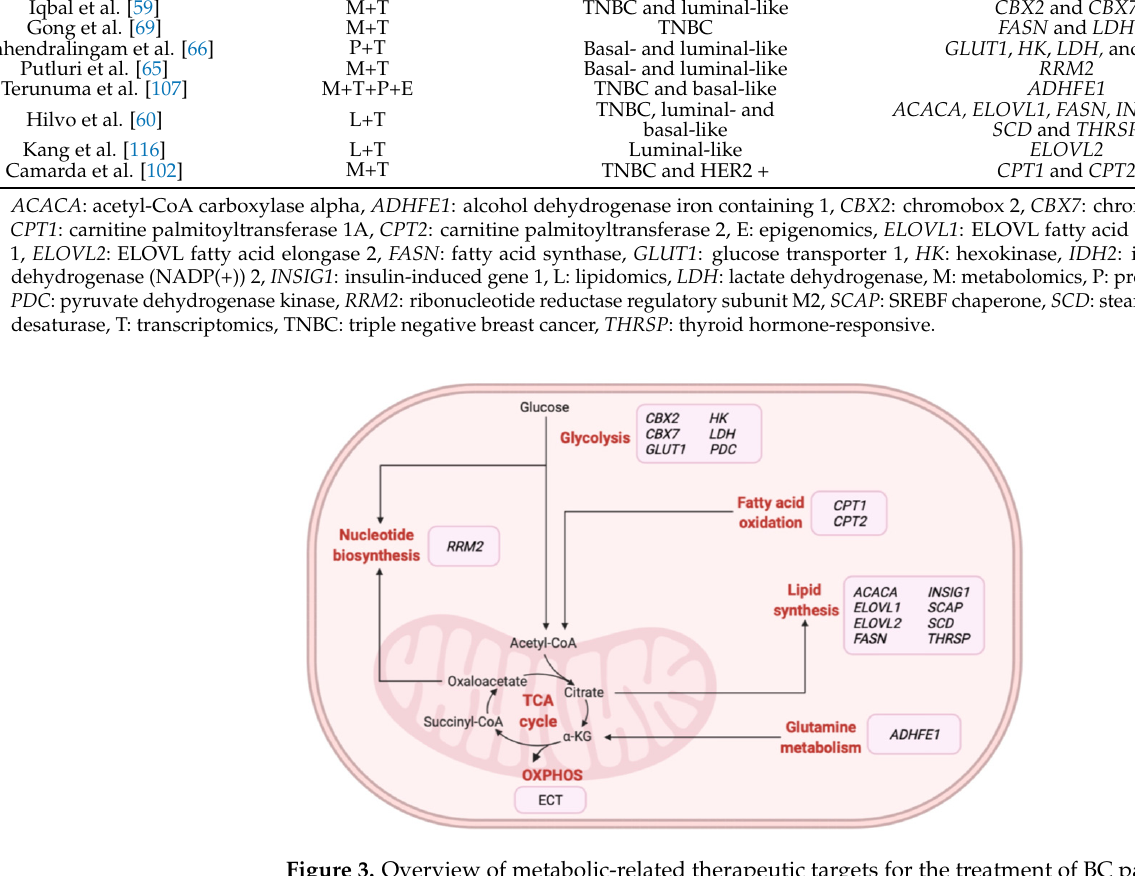
Table 4. Multi-omics studies focused on developing new therapeutic strategies for the treatment of